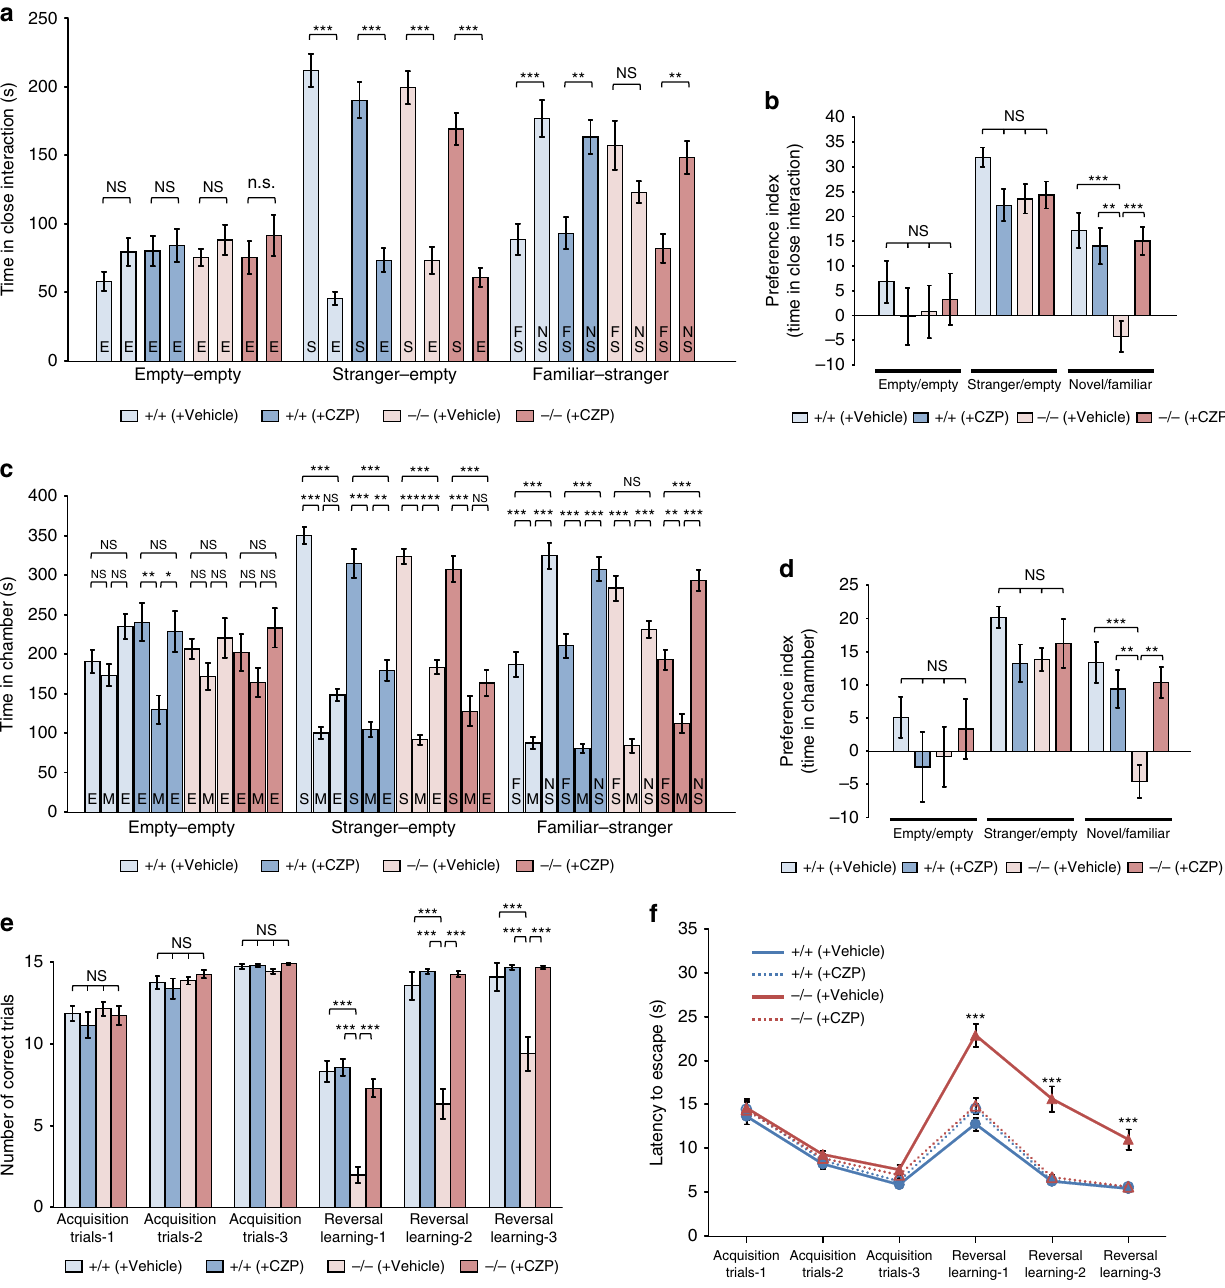
Figure 7 | CZP shows an ameliorating effect on impaired social interaction and inflexible behavioural change in PX-RICS (cid:2) / (cid:2)